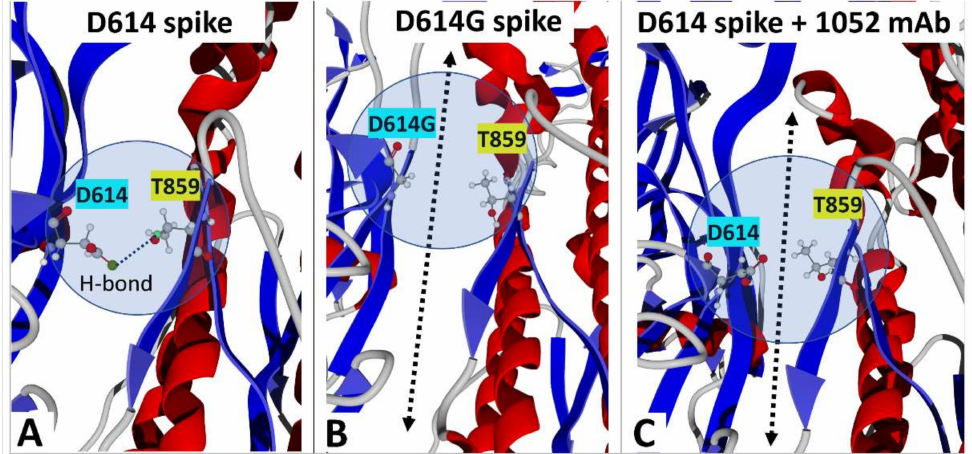
Figure 2. How the D614G mutation and the ADE antibody 1052 enhance SARS-CoV-2 infectivity. ( A ) Hydrogen bond between D614 (chain B) and T859 (chain C) stabilizing the trimeric spike protein (PDB: 6VSB). ( B ) The D614G mutation renders impossible the formation of the hydrogen bond and facilitates the conformational change inducing the demasking of the RBD (PDB: 7BNM). ( C ) Binding of ADE antibody 1052 breaks the hydrogen bond between D614 and T859 (PDB: 7LAB). The arrow in panels B and C illustrates the lack of contact between vicinal spike protein monomers in the context of the trimeric